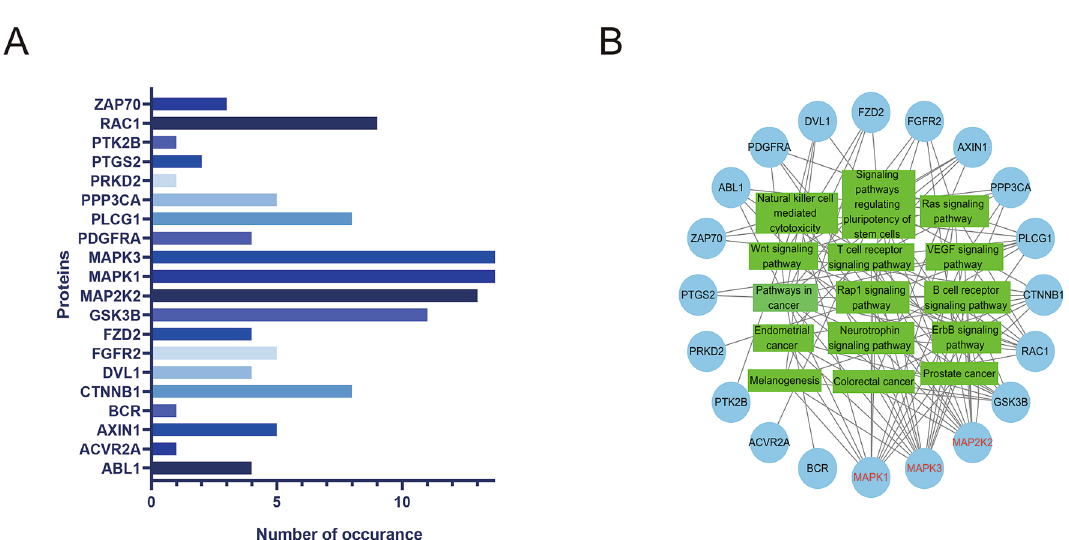
Figure 5. The numbers of target proteins of the top 15 signaling pathways with the highest enrichment ratio. ( A ) The number of occurrences of each target protein in the top 15 signaling pathways. ( B ) The circles represent the target proteins, and the squares represent the signaling pathways. The number of lines between the square and the circle represents the number of